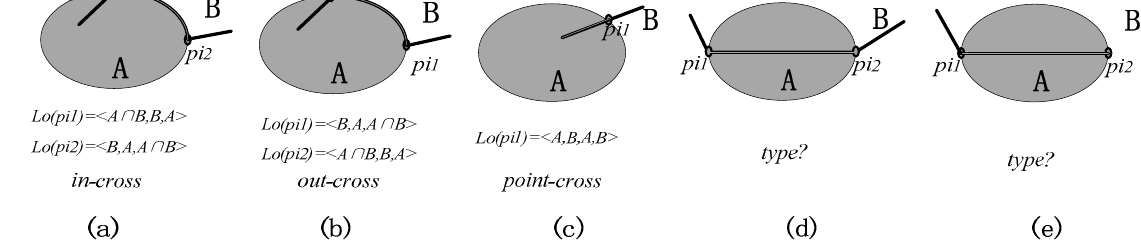
Figure 2. The incompleteness of the LRBIS (intersections set between line and region boundary) method. ( a ) A in-cross type defined by the LRBIS method; ( b ) A out-cross type defined the LRBIS method; ( c ) A point-cross type defined the LRBIS method; ( d ) One cross type omitted by the LRBIS method; ( e ) The other cross type omitted by the LRBIS method.